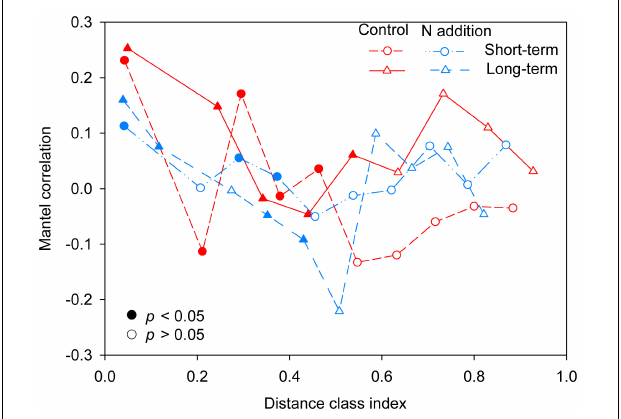
FIGURE 4 | Phylogenetic mantel correlogram between the Euclidean distance matrix of OTU niche values and phylogenetic distance matrix. Solid and open symbols denote significant ( p < 0.05) and non-significant ( p > 0.05) correlations (phylogenetic signal),